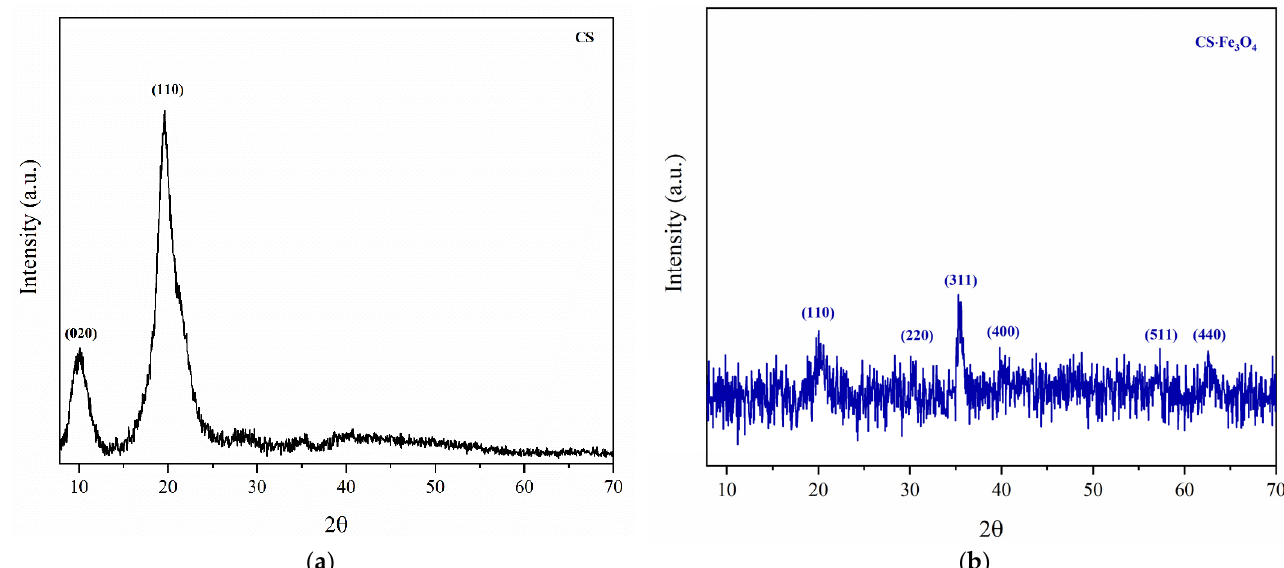
Figure 3 . X-ray diffraction: ( a ) chitosan and ( b ) magnetic chitosan.